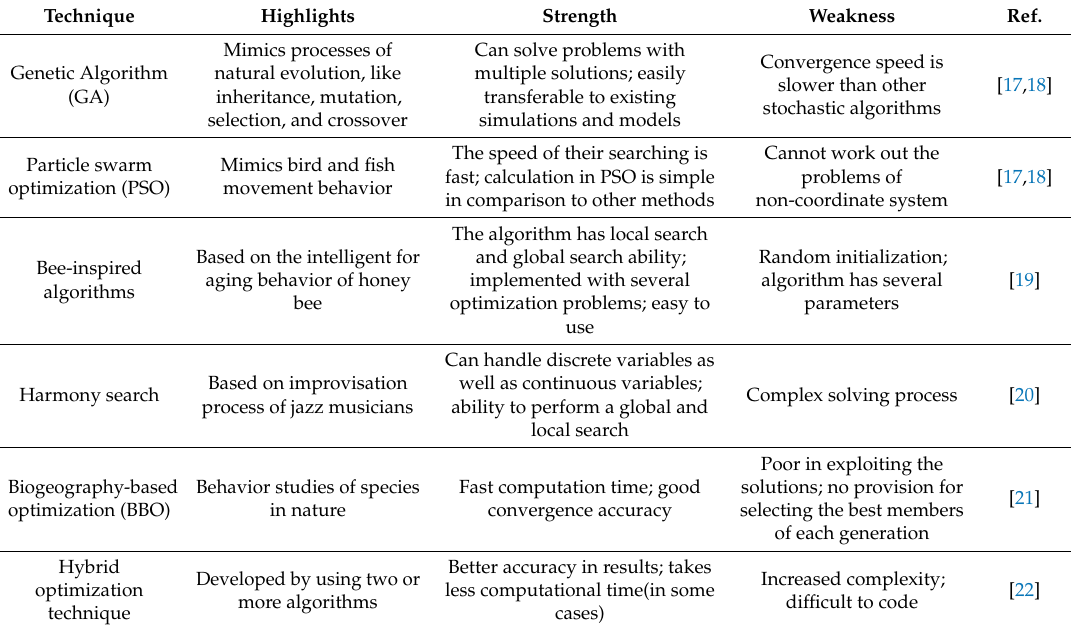
Table 2. Comparison of optimization techniques.